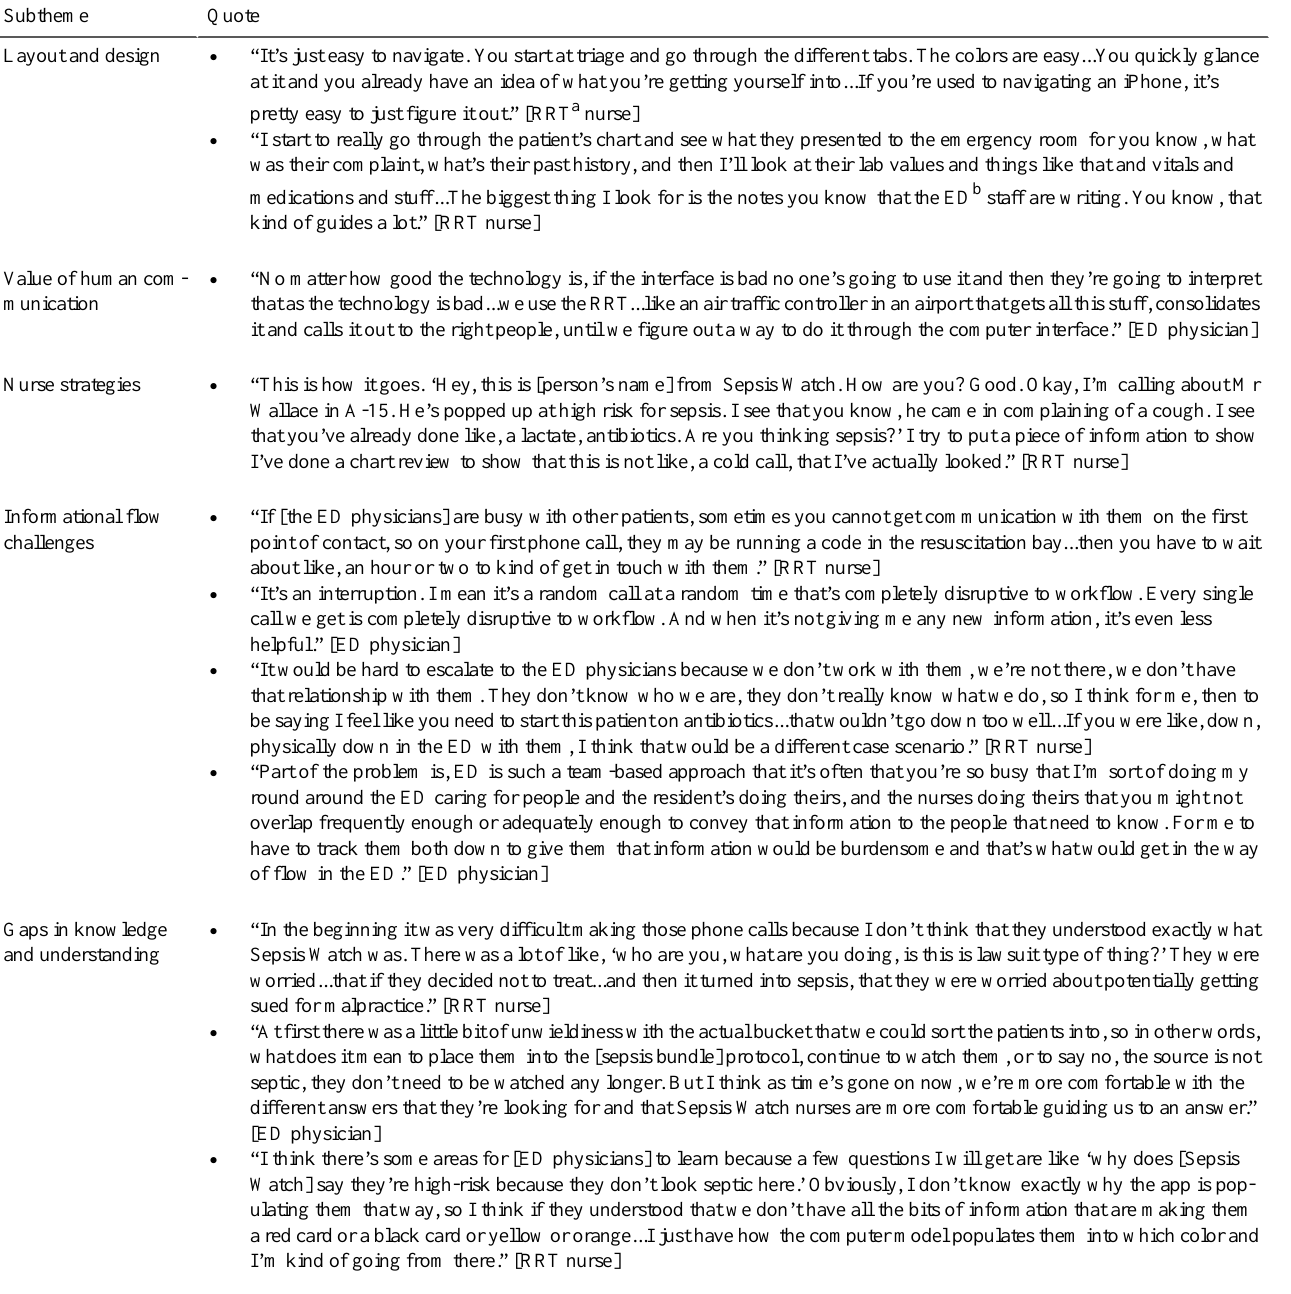
Table 5. Representative quotations on the implementation of Sepsis Watch